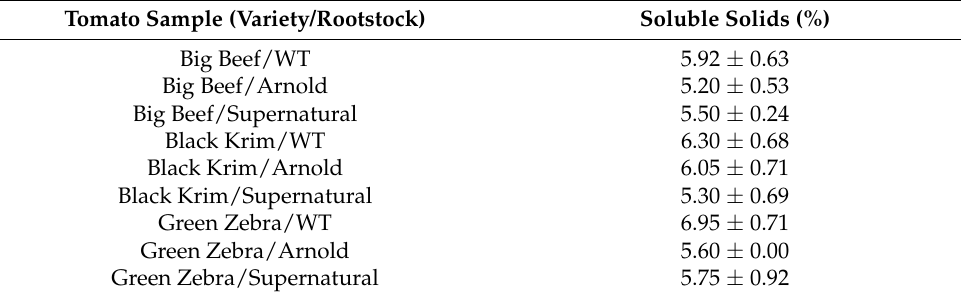
Table 1. The soluble solid content of tomato samples (mean ± std).